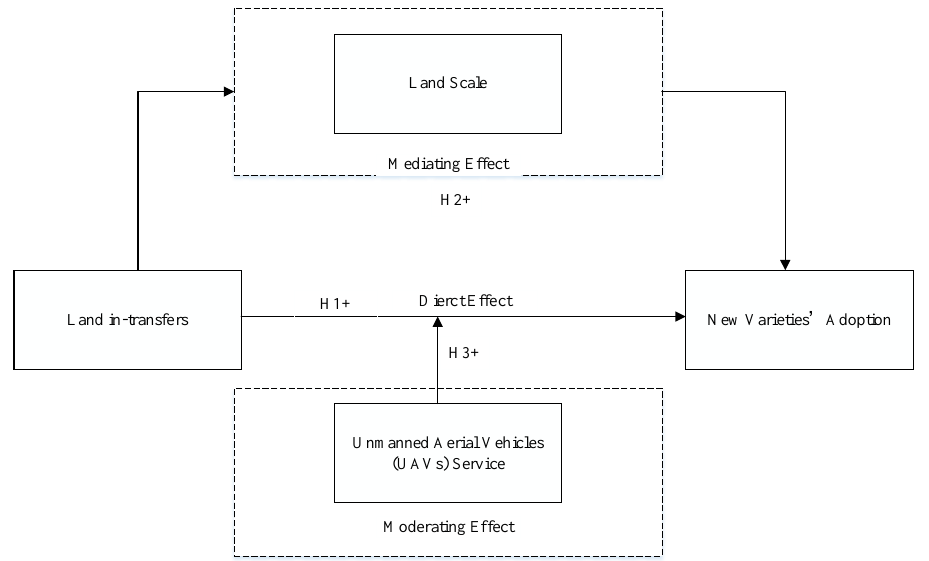
Figure 1. The conceptual model of land in-transfers on the adoption of new kiwi varieties.